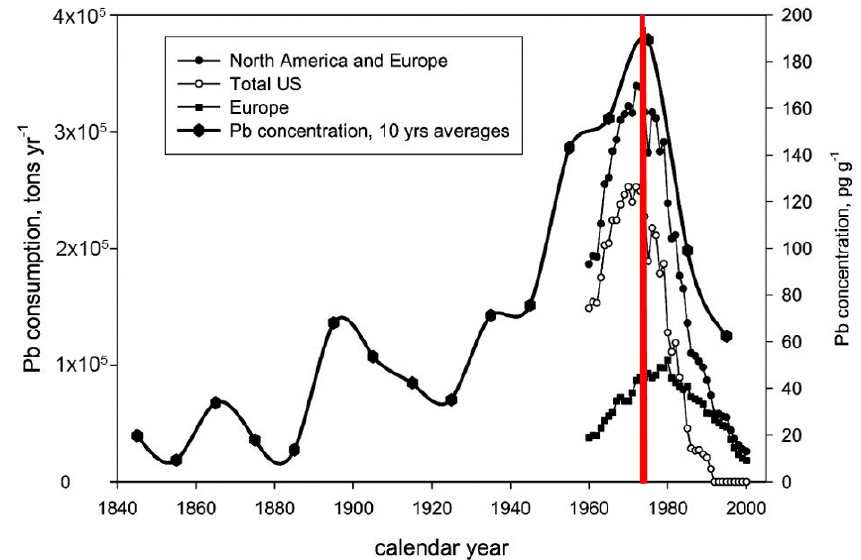
Figure 1. The increase of lead dust accumulation in Arctic snow before and after the U.S. 1975 (red line) catalytic converter installation requirements for all new cars. European countries made the same requirements in 1980. Modified from [4].